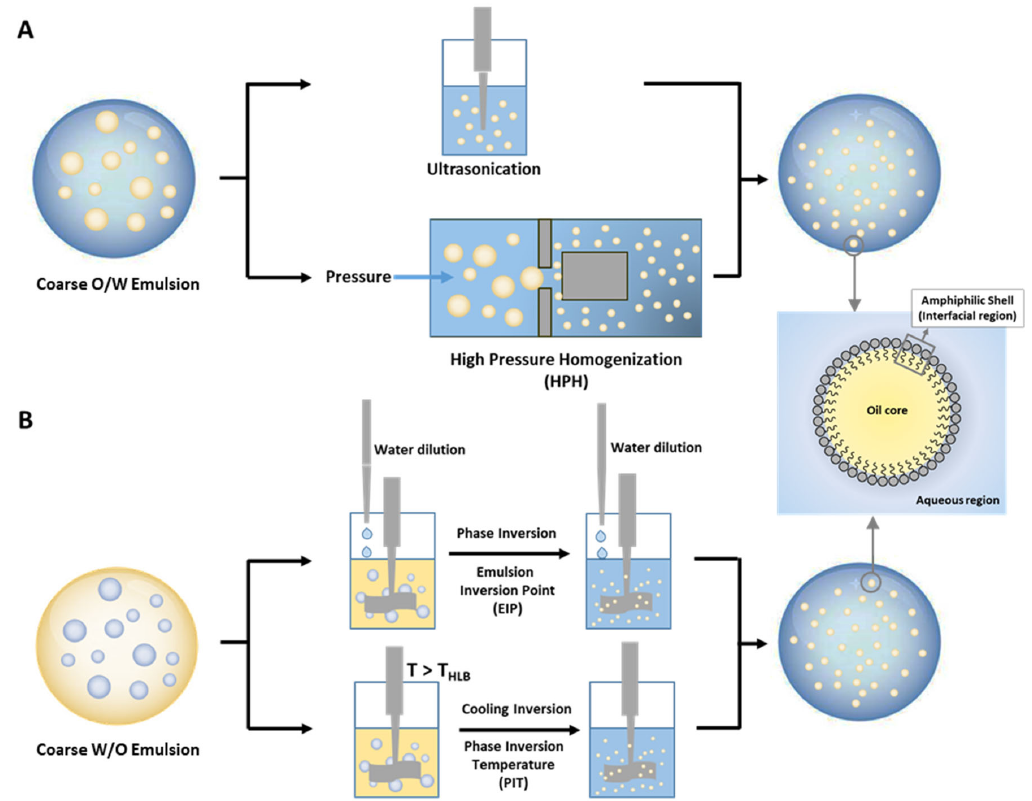
Figure 6. Common methods for preparing oil-in-water nanoemulsions. ( A ) The high energy methods, such as high pressure homogenization (HPH) and ultrasonication, break coarse emulsions drops into smaller droplets. ( B ) The low-energy methods start with W/O coarse emulsions, and droplets are broken into smaller droplets during the low interfacial tension state that occurs during phase transition, induced by the water dilution. In the phase inversion temperature (PIT) method, the phase inversion occurs by cooling the mixture. W/O nanoemulsions can be prepared by employing the same method ‐ ology.